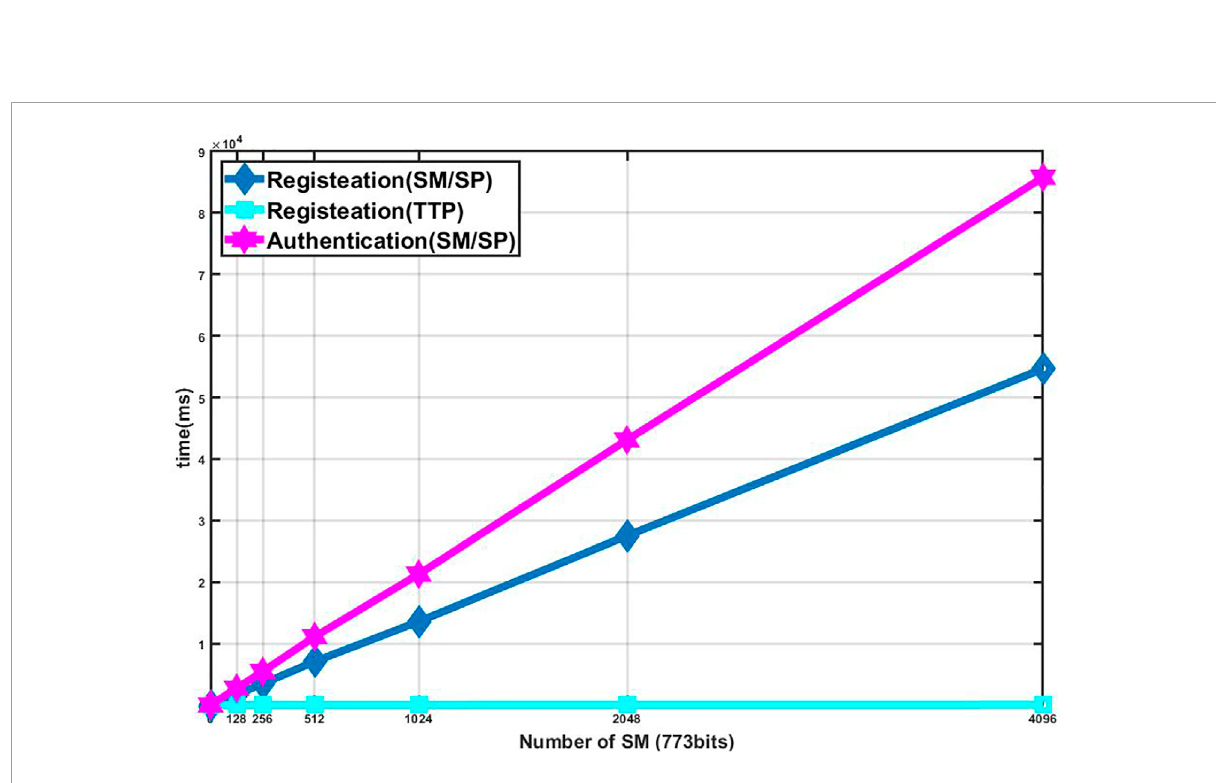
FIGURE 6 Time cost under different numbers of